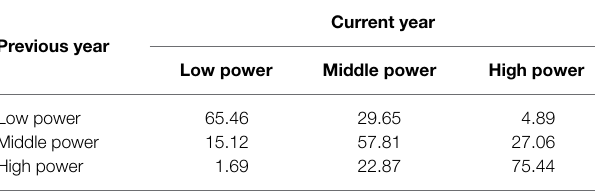
TABLE 2 | Transition probabilities for power